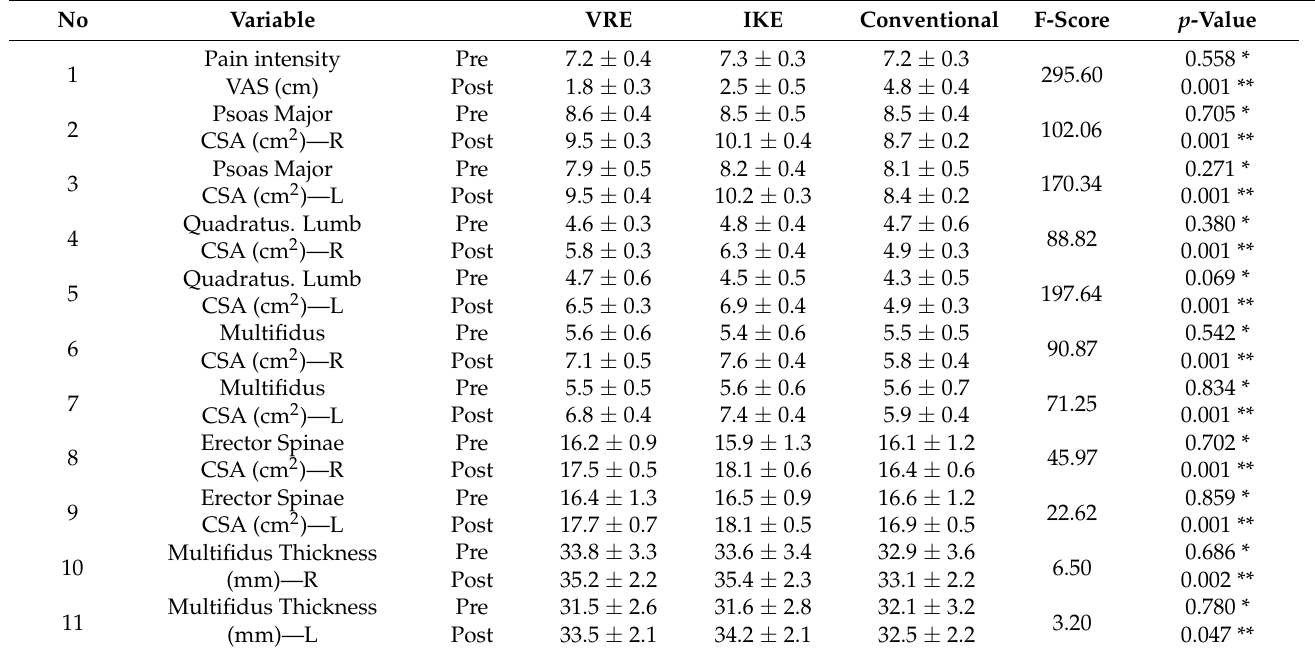
Table 2. Mean and SD of pre and post MRI and ultrasound measures of VRE, IKE, and conventional groups.